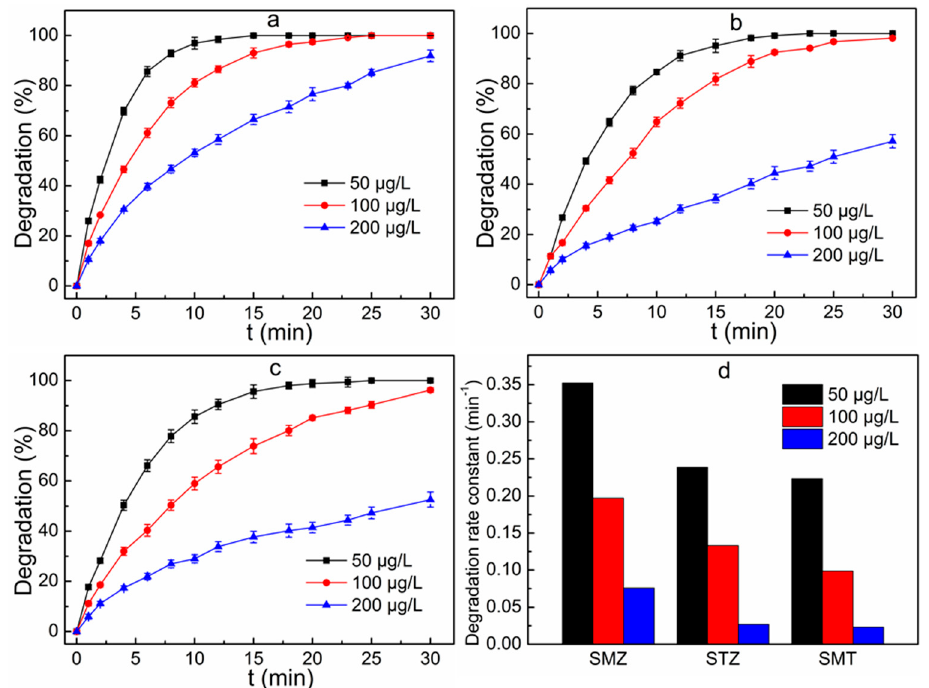
Figure 2. Effect of initial concentration of the mixed solution on the removal of SMZ ( a ), STZ ( b ) and SMT ( c ) and degradation rate constants for sulfonamides degradation at different initial concentration of the mixed solution ( d ). Reaction conditions: UV light intensity 5 W, H 2 O 2 dosage 55 mg L − 1 .